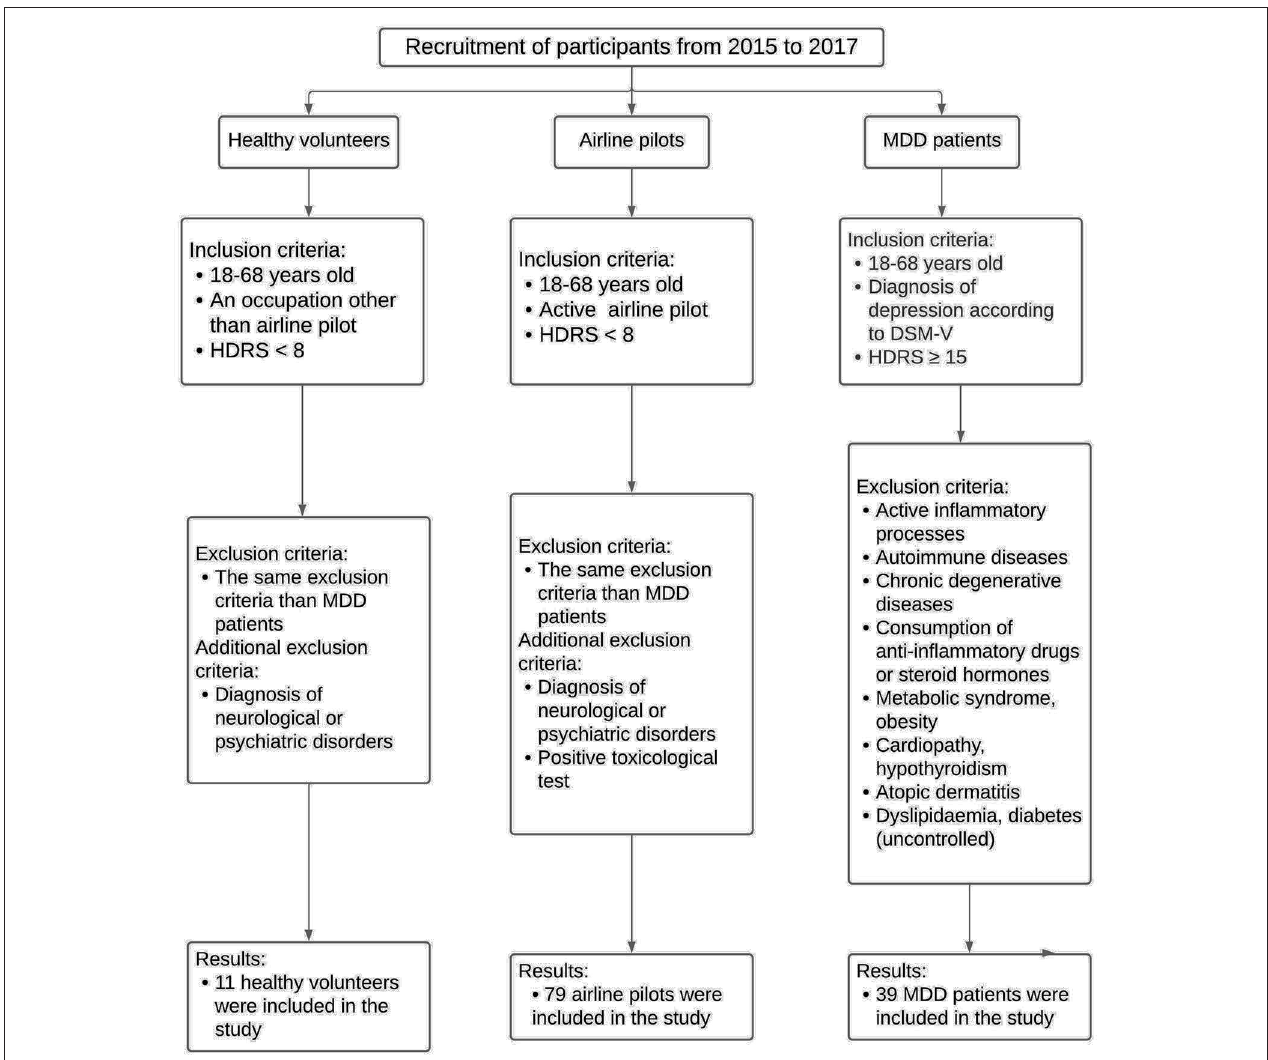
FIGURE 1 | Flow diagram of participant recruitment. The figure describes the inclusion and exclusion criteria for healthy volunteers, airline pilots, and MDD patients.